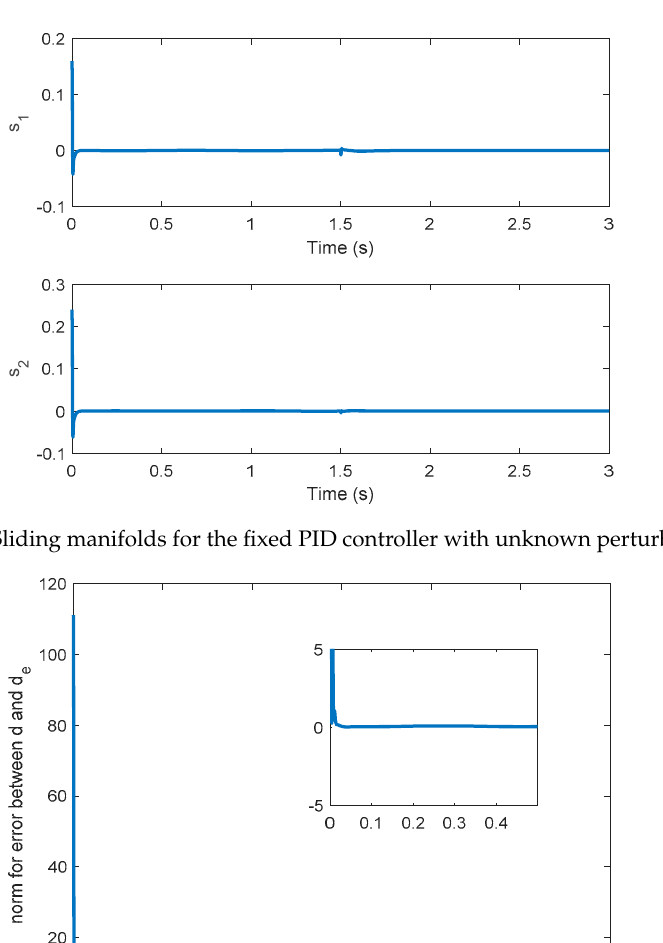
Figure 4. Control inputs based on the fixed PID controller and unknown perturbation.